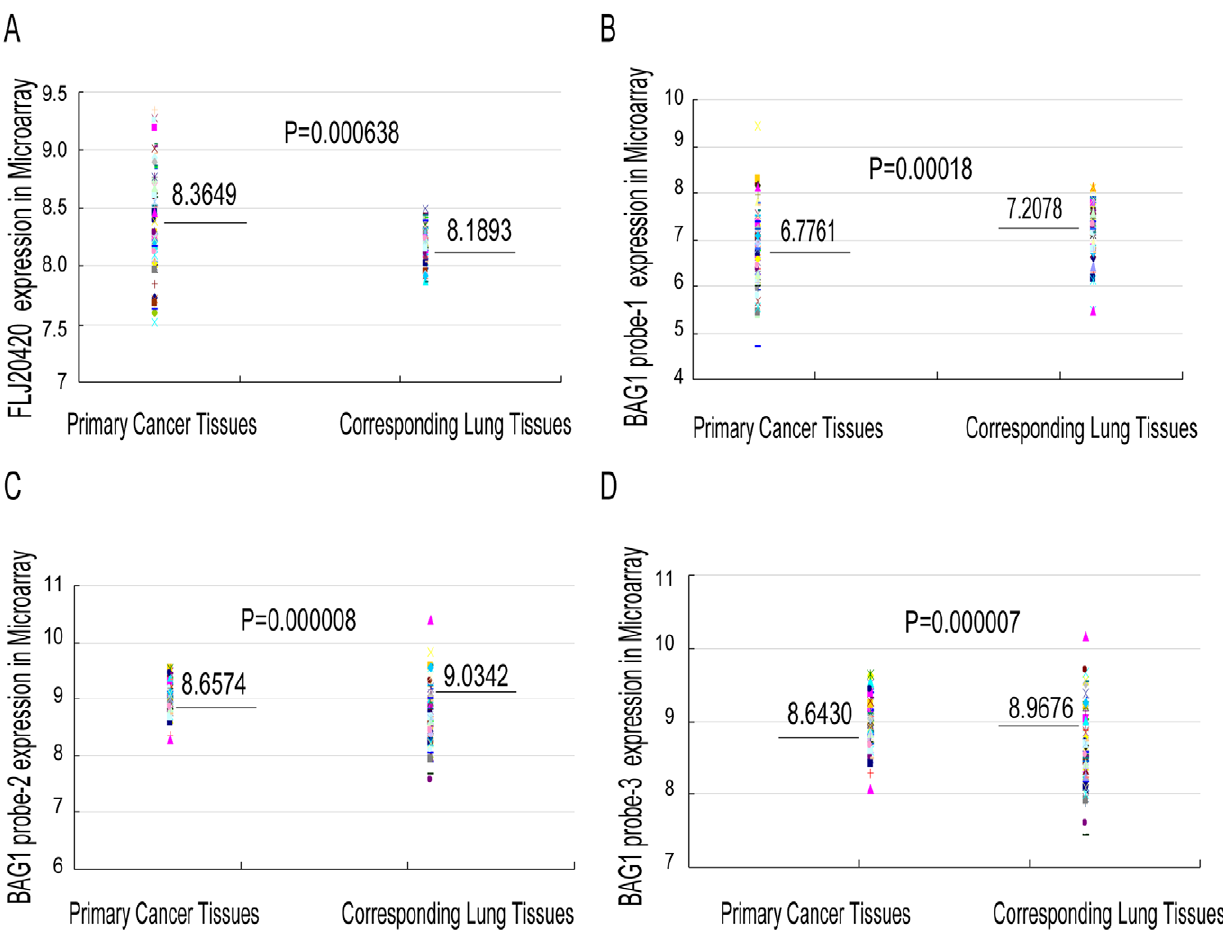
Figure 6. FLJ20420 and BAG-1 gene expression in lung tumor tissues. Microarray analysis of FLJ20420 (A) and BAG-1 in lung tumor tissues (B-D), relative to the paired normal lung tissues.